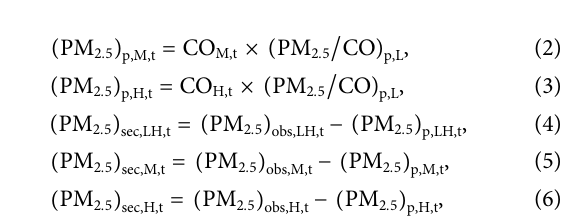
Frontiers in Environmental Science |